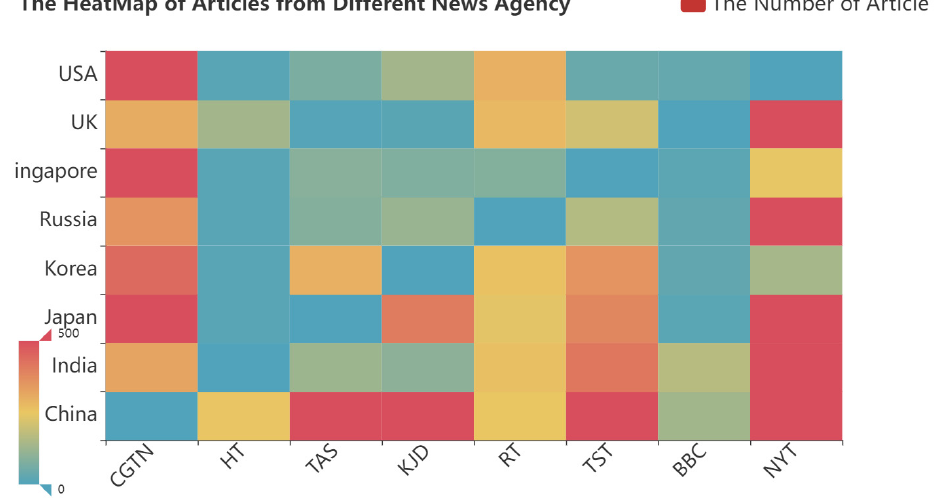
Figure 5. The number of COVID-19-related articles from news agencies reporting on different coun- tries.